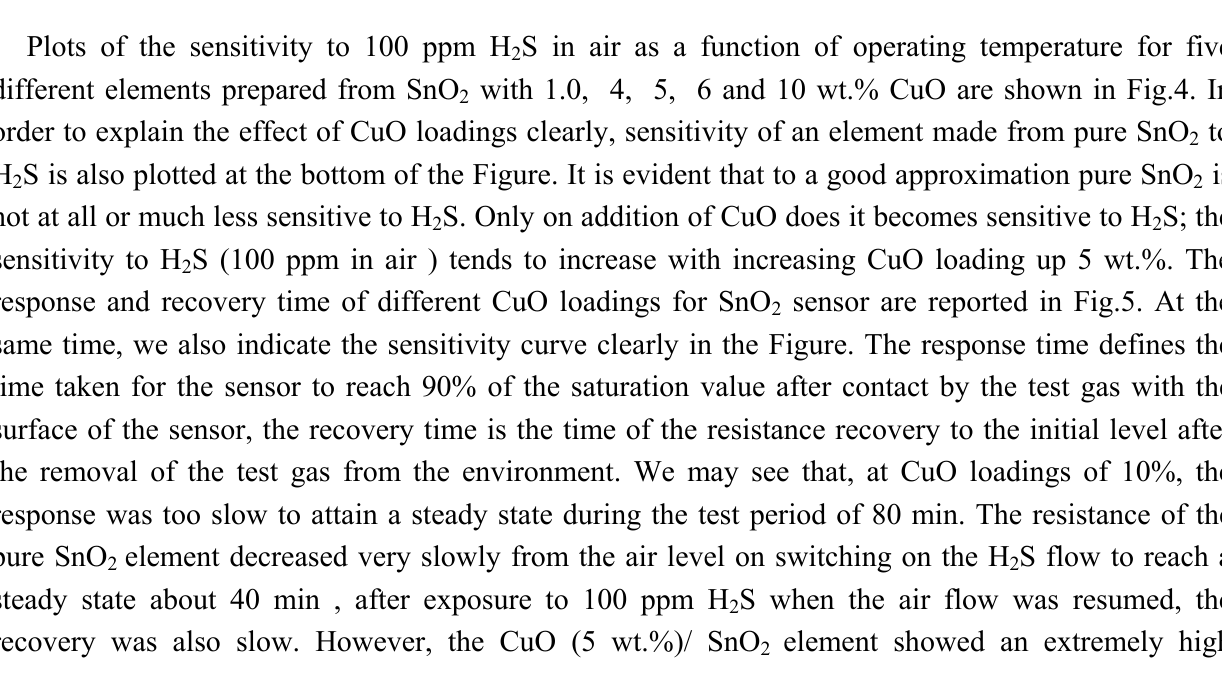
Figure 3. The sensitivity of the sensor element as a function of H different operation